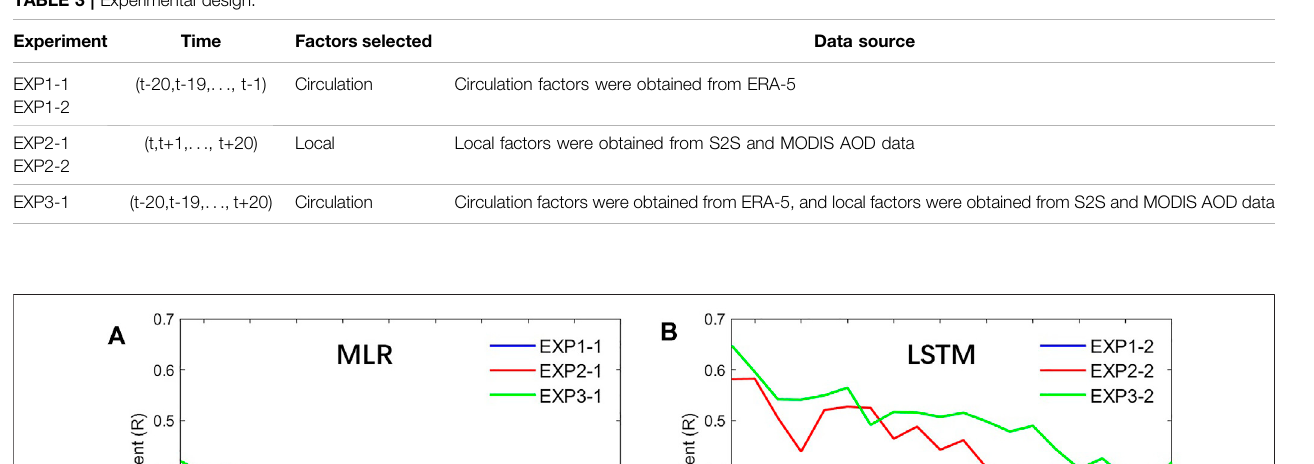
the LSTM network. Experiment 2: A total of 207 historical predictors (t, t + 1,..., t + 20) from the three models in the to establish a forecast model for 0- to 20-day PM 2.5 concentration. The model in EXP2-1 was built using MLR regression, and the forecast model in EXP2-2 was built using